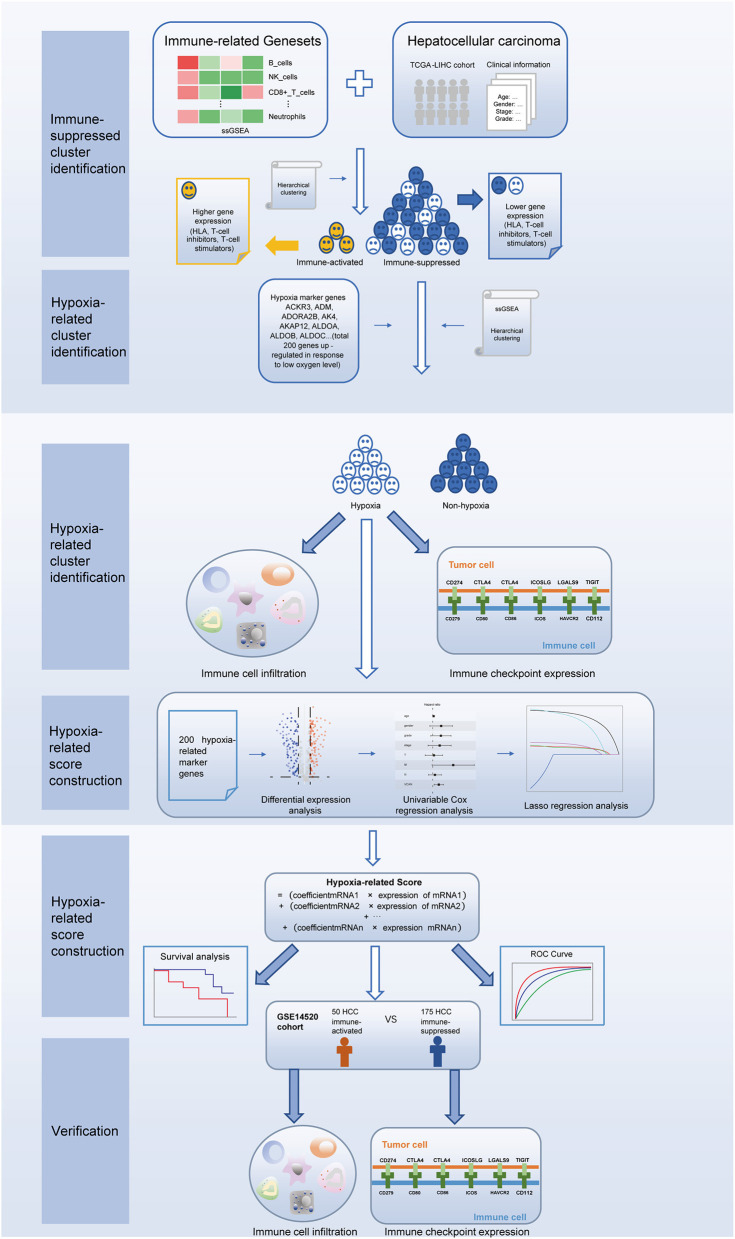
Study flowchart.